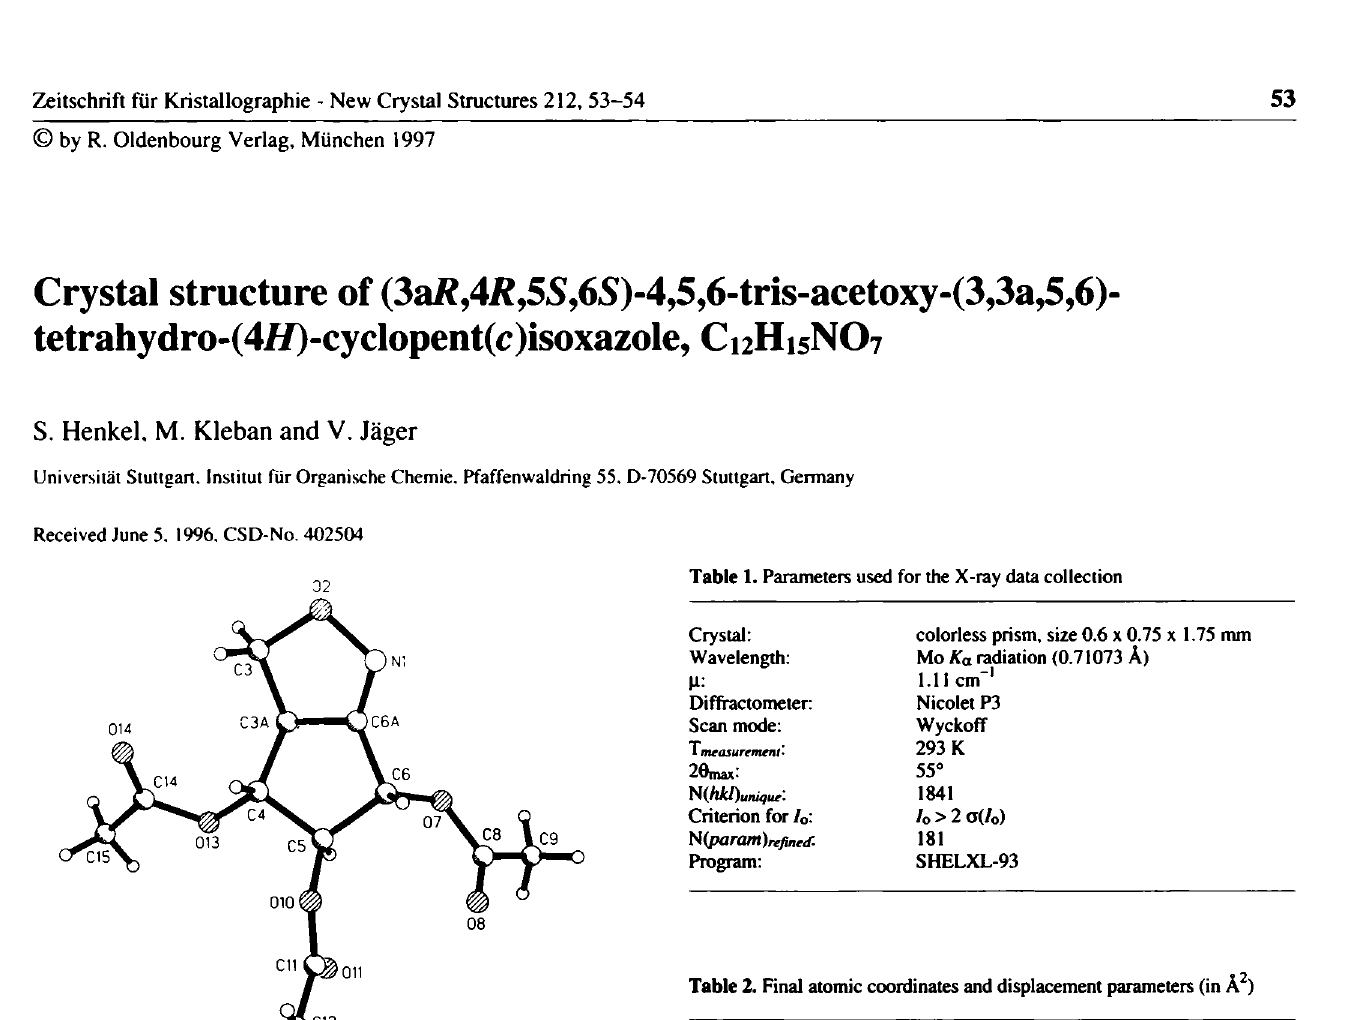
Table 2. Final atomic coordinates and displacement parameters (in Â 2 )